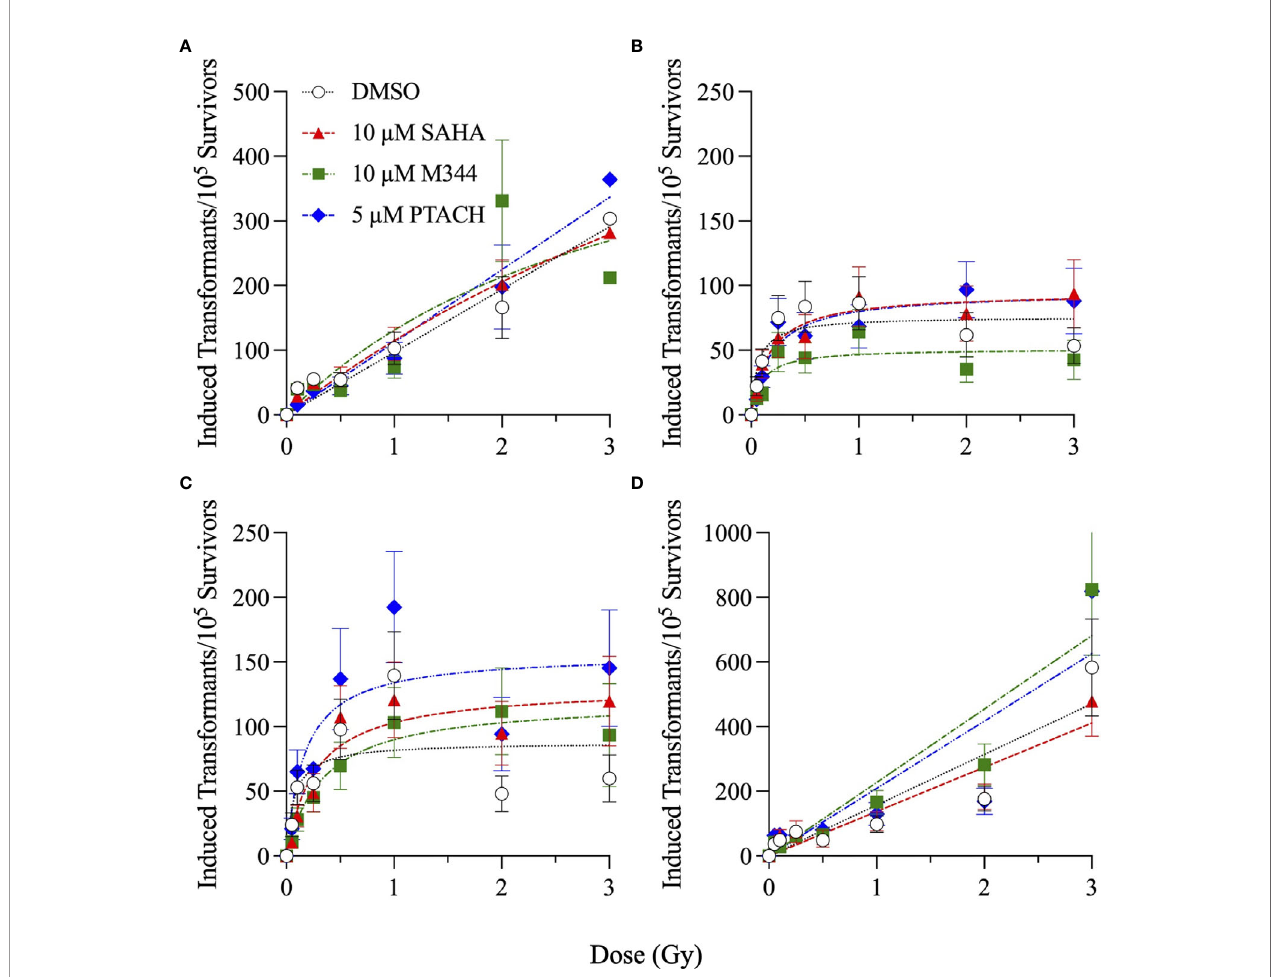
FIGURE 10 | Cellular transformation of asynchronously growing normal NFF28 primary fi broblasts pretreated for 18 h with 10 µM SAHA, 10 µM M344, and 5 µM PTACH and irradiated cesium-137 g -rays (A) , 200 MeV protons (B) , 290 MeV/n C-12 ions (C) , or 350 MeV/n O-16 ions (D) measured as the acquisition of anchorage-independent colony formation in soft agar per 10 5 surviving cells. Data reported as mean ± SEM; where error bars are not visible, they are smaller than the data point. A hyperlinear response is observed for low-dose exposures with transformation frequencies peaking at 1 Gy and then declining at higher doses following proton and C-12 ion